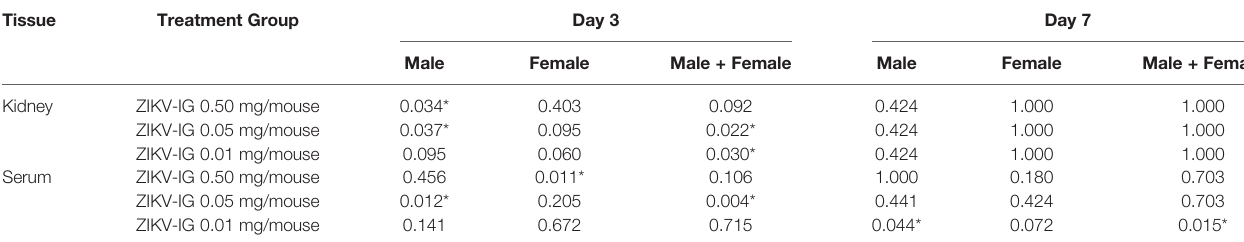
TABLE 3 | Analysis of viral titer in ZIKV-IG treated mice 3 and 7 days post Zika virus infection. Tissue Treatment Group